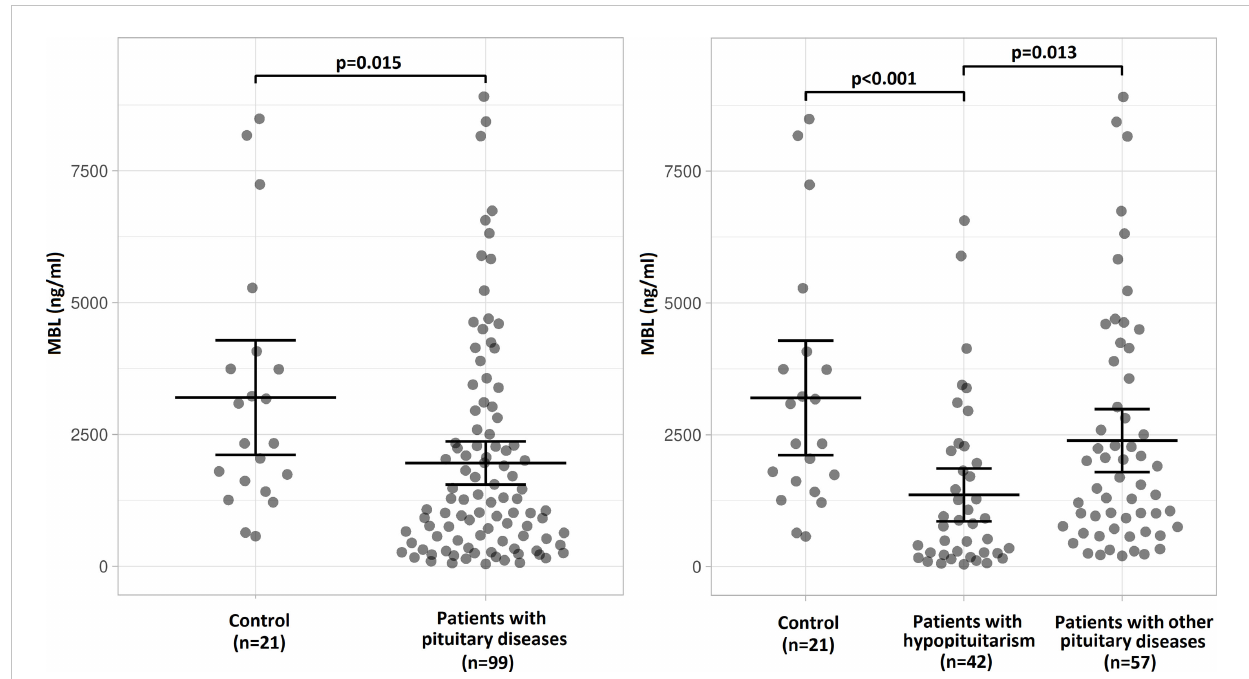
FIGURE 2 Mean (± SEM) values of mannan-binding lectin (MBL) level in control individuals (n=21) and in patients with pituitary diseases (n=99) (left) or mean (± SEM) values of MBL level in control individuals (n=21), in patients with hypopituitarism (n=42) and in patients with other pituitary diseases (n=57) (right). Statistical evaluation was performed by an unpaired Student ’ s t -test. The statistical differences are marked in the